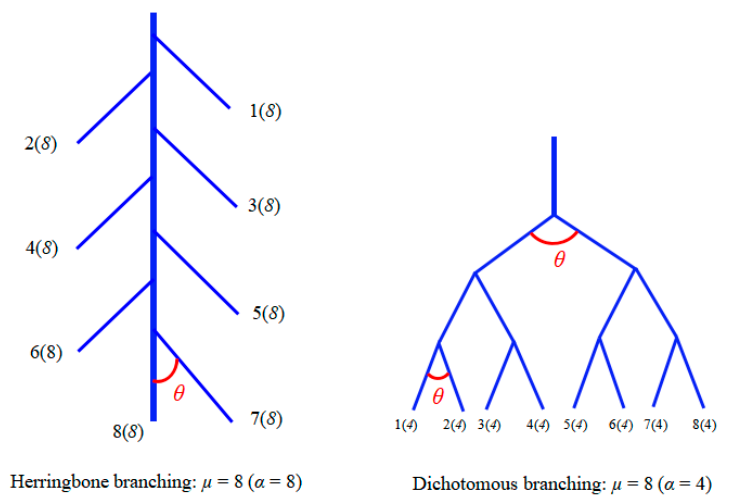
Figure 1. Schematic of root topology classification.